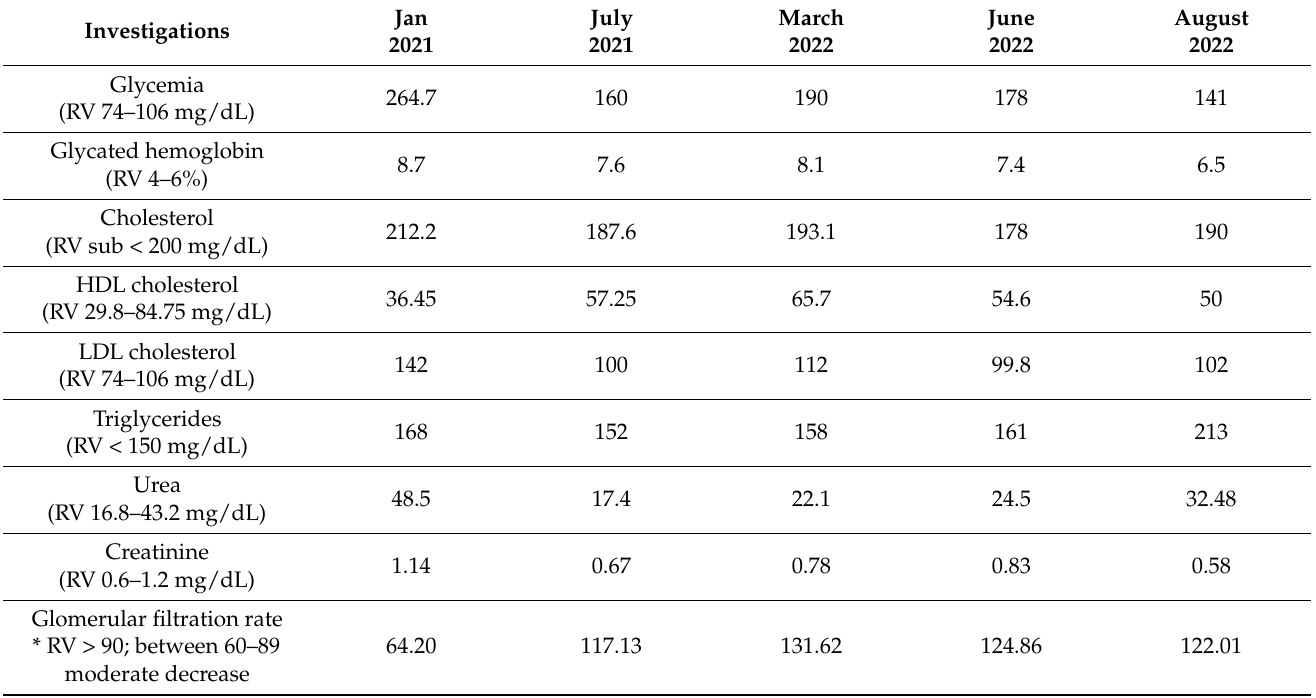
Table 1. Laboratory Investigations.